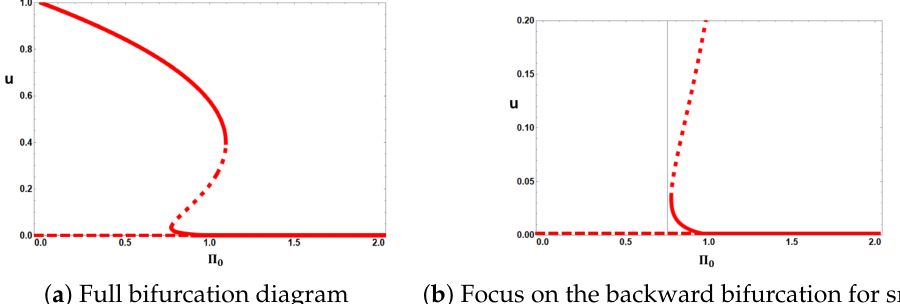
Figure 4. A bifurcation diagram linking steady state criminal activity levels to policing efficiency when police recruitment is linked to criminal activity. Solid lines correspond to stable steady states and dashed lines to unstable steady states. The parameters used to create these figures were a = 0.2, b = 1.6 and c = 0.06 which means that the system represents the scenario of low policing responsive- ness to criminal activity. Moreover, since a + c < 1, the bistable dynamics predicted in Table 1 are observed. In ( a ), the full bifurcation diagram is presented; in ( b ), we have zoomed in around the backward bifurcation.